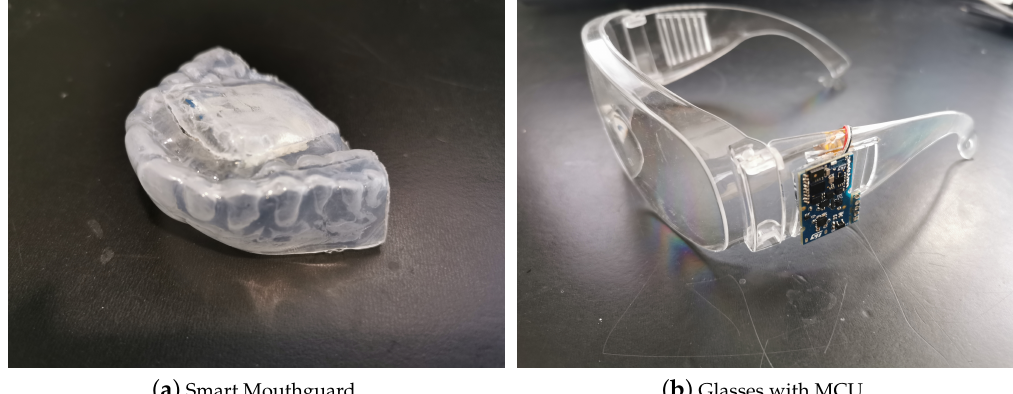
Figure 2. Devices used in this